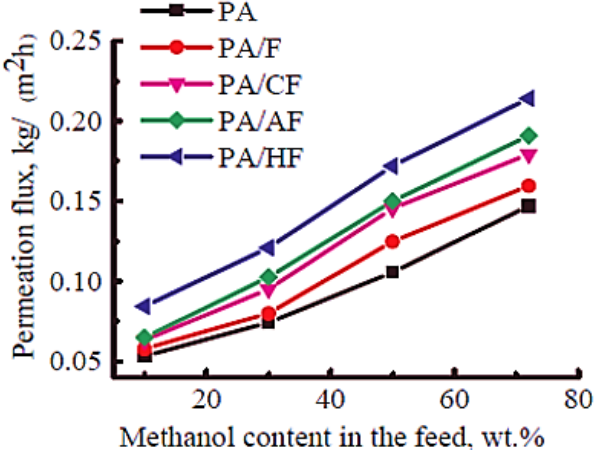
Figure 8. Dependence of the permeation flux on the methanol content in feed for membranes based on neat PA and nanocomposites with fullerene and fullerene derivatives during pervaporation of methanol − toluene mixtures with 10 – 72 wt % methanol (22 °C) [166]. PA, polyphenylene isophthalamide; PA/F, polyphenylene isophthalamide/fullerene; PA/CF, polyphenylene isophthalamide/carboxyfullerene; PA/AF, polyphenylene isophthalamide/fullerene derivative with L-arginine; PA/HF, polyphenylene isophthalamide/polyhydroxylated fullerene. Reproduced with permission from Elsevier.